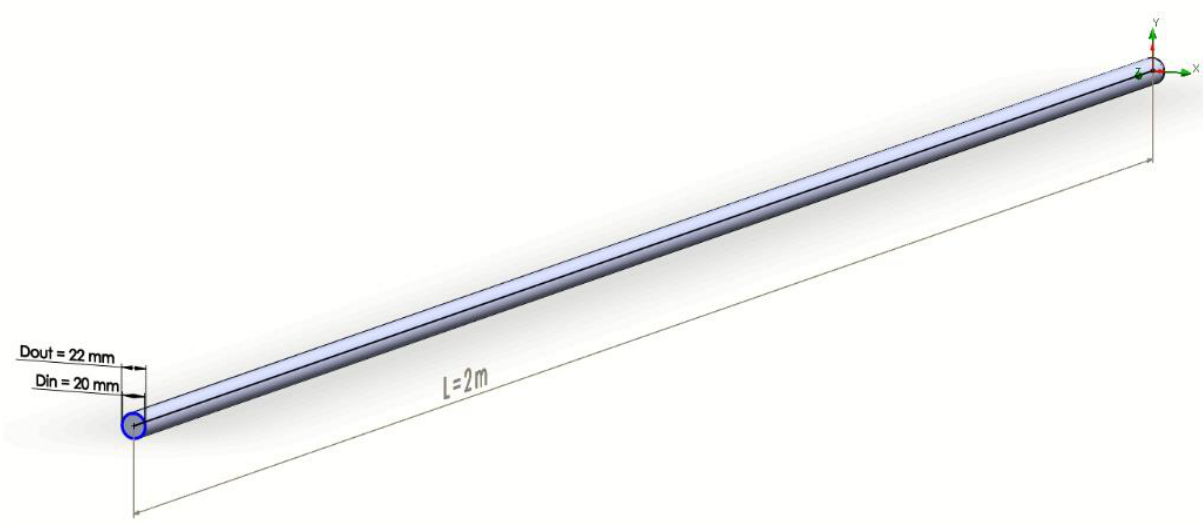
Figure 1. The examined tube for the performed simulations.